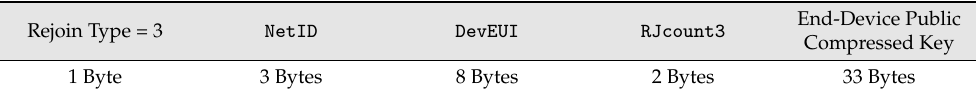
Table 5. Rejoin-Request type 3 packet